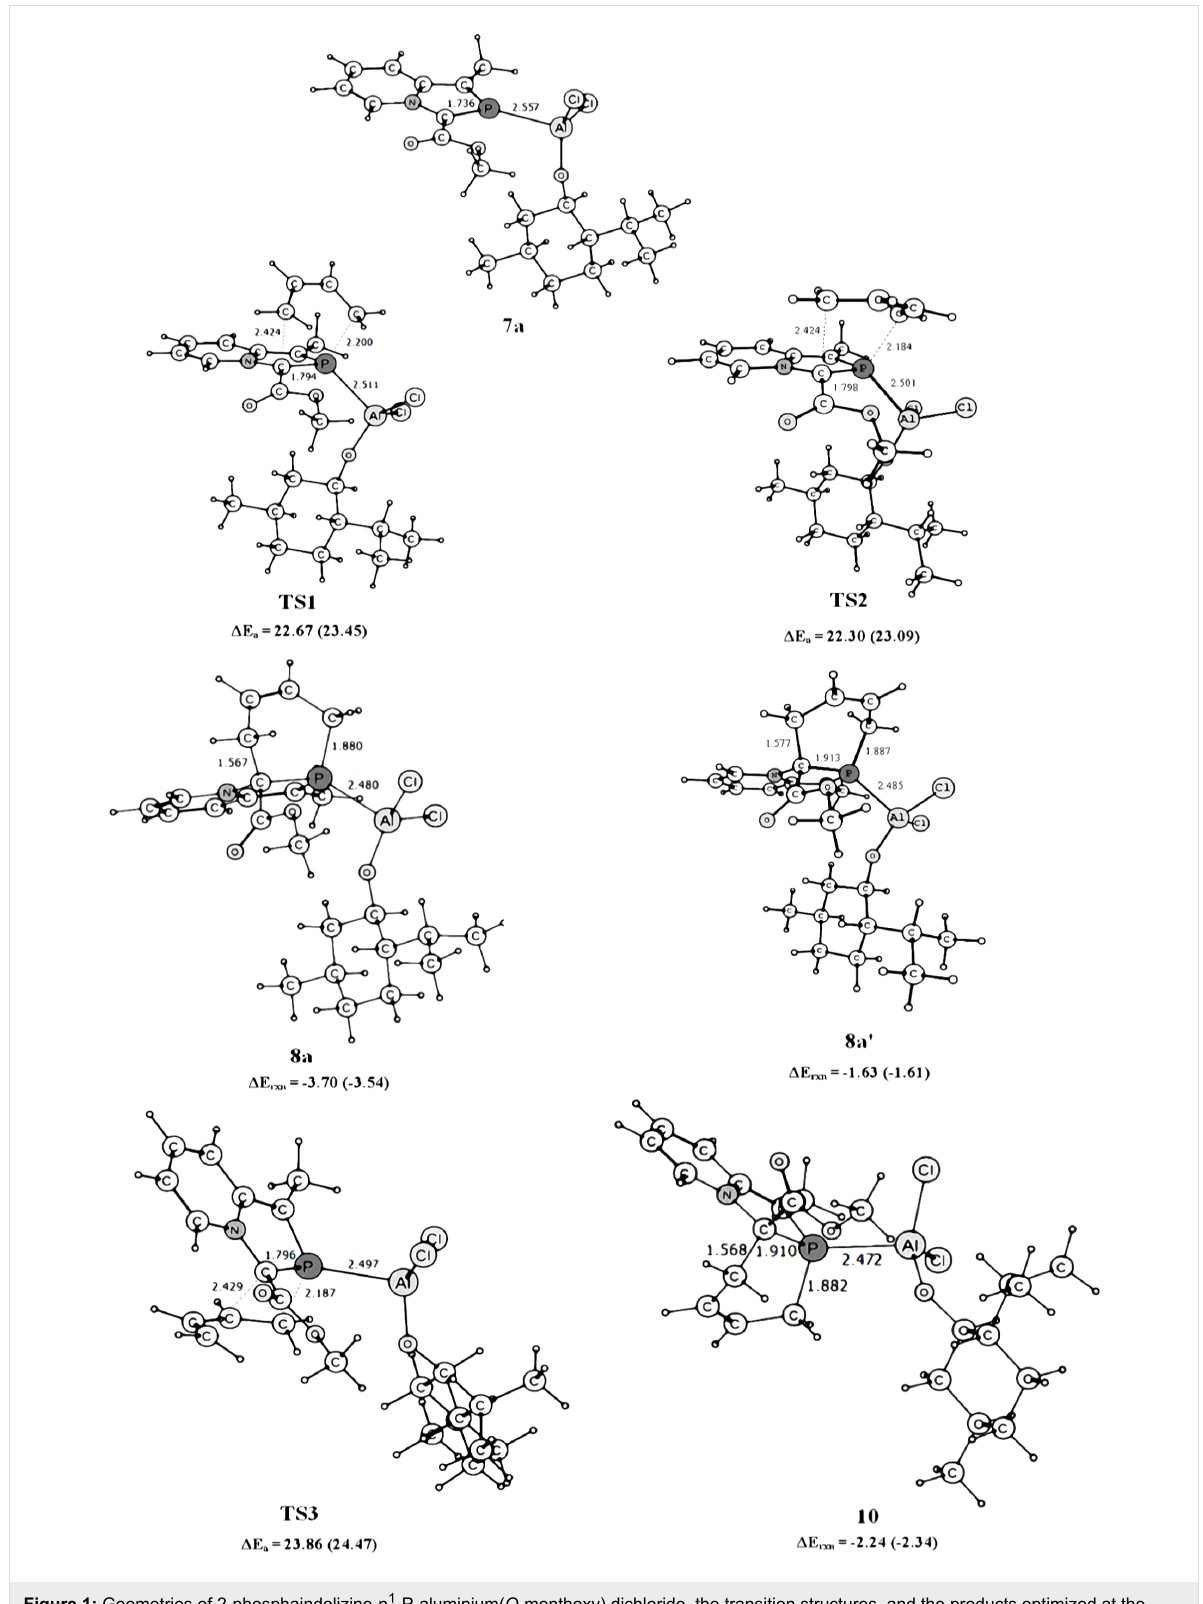
Figure 1: Geometries of 2-phosphaindolizine- η 1 -P-aluminium( O -menthoxy) dichloride, the transition structures, and the products optimized at the B3LYP/6-31+G* level in the gas-phase. The relative activation and reaction energies obtained in methylene chloride are given in